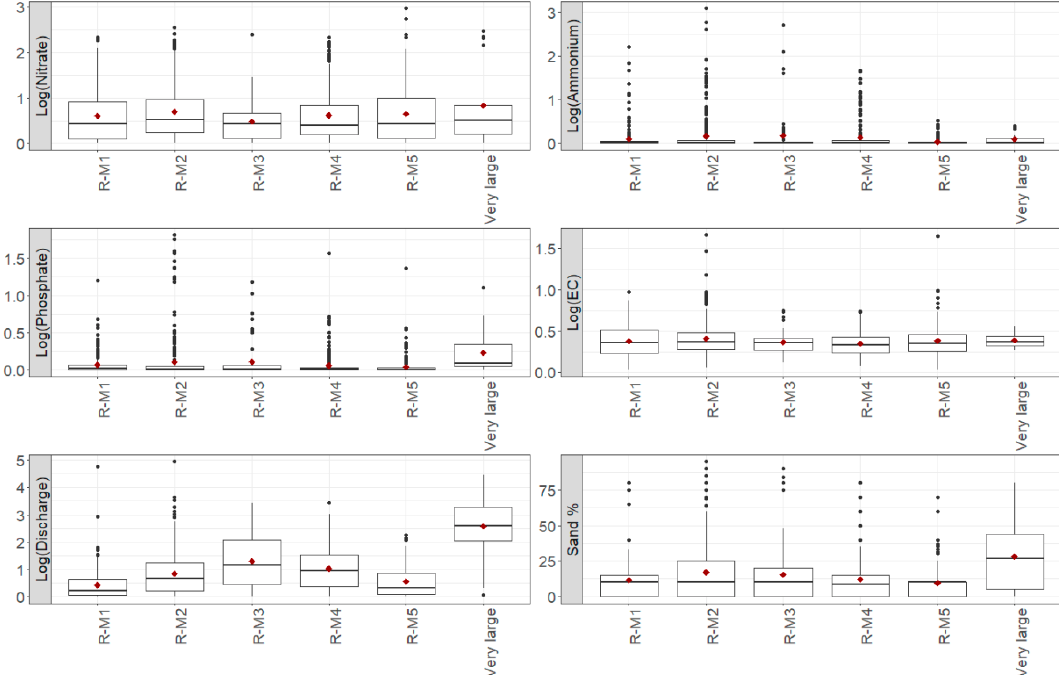
Figure 8. Boxplots for key variables per intercalibration river type (ICT). The red dot represents mean values.